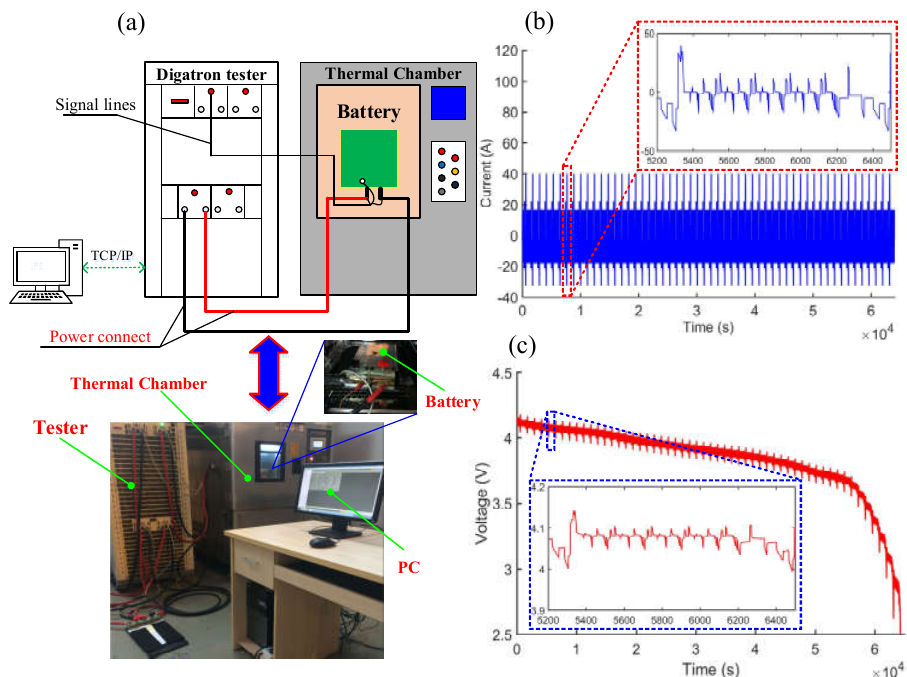
Figure 1. Battery test bench and experimental results under the New European Driving Cycle (NEDC) working cycles. ( a ) Schematic of the test bench; ( b ) current profile; and ( c ) voltage profile.